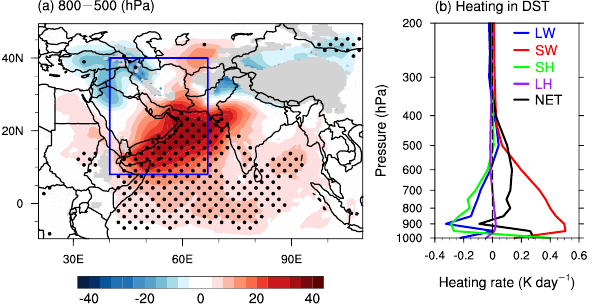
Figure 14. (a) Spatial pattern of the ensemble mean differences in thickness between 800 and 500hPa pressure layers between the ALLF and NDST experiments (unit: m). (b) Vertical profiles of the ensemble mean differences in atmospheric heating rate area- averaged in DST (box in a ) between the ALLF and NDST exper- iments (units: Kday − 1 ) . The dots in (a) indicate that the radiative effect has a 95% confidence level based on a one-sided Student’s t test. All heating rates are for all-sky conditions. “SH”, “LH”, and “NET” stand for sensible heating, latent heating, and net heating rate. Net heating is the sum of SW, LW, SH, and LH.